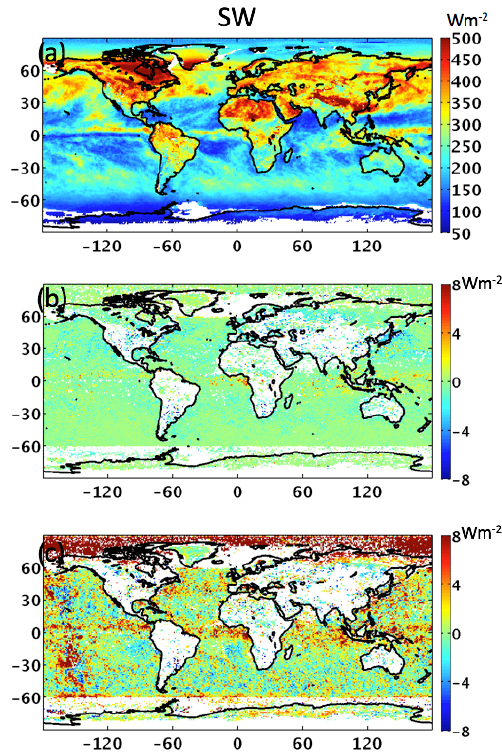
Figure 7. The gridded monthly mean TOA instantaneous SW fluxes from the simulated Aqua footprints ( F s a , a ), the flux differences caused by footprint size difference between simulated NPP and sim- ulated Aqua ( F s n − F s a , b ), and the flux differences caused by both footprint size and cloud property differences ( F (cid:48) ns − F s a , c ) using April 2013 data. Regions shown in white have large sample number differences between simulated Aqua and simulated NPP.